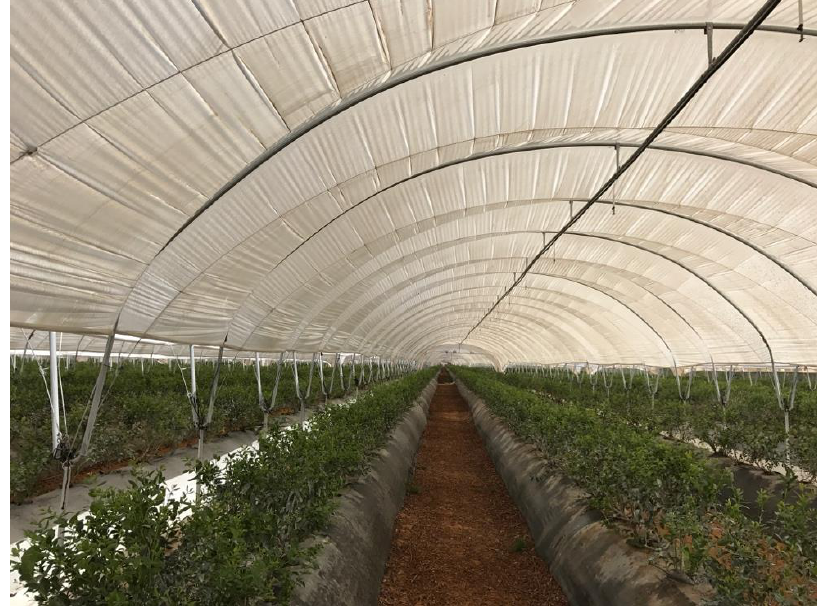
Figure 3. Southern highbush blueberry in a high tunnel production system.